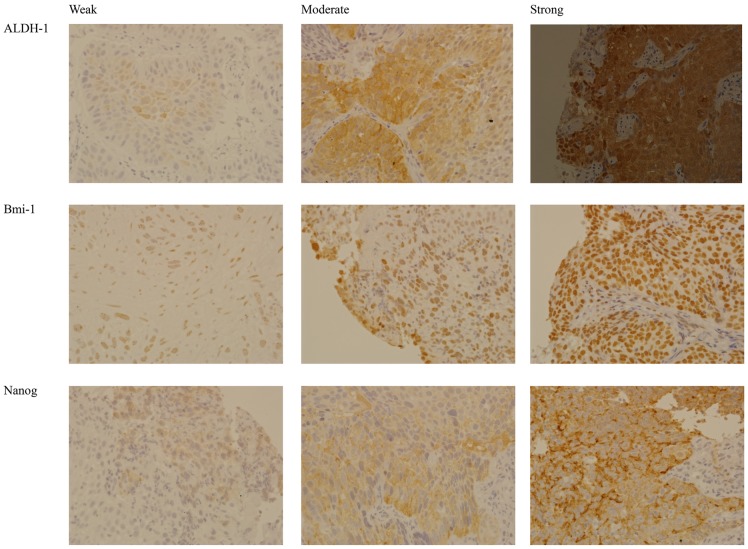
Representative images of cancer stem cell markers (top: ALDH1, middle: Bmi-1, bottom: Nanog) with different stain intensities (weak, moderate, strong).